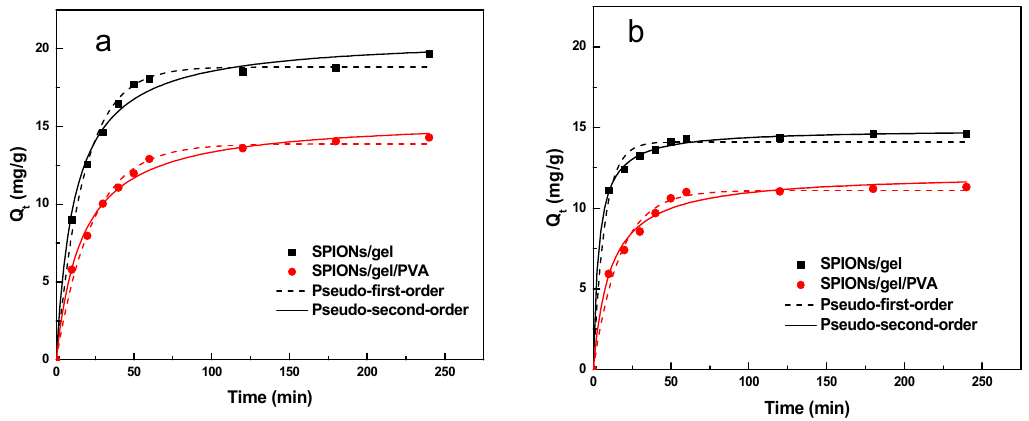
Figure 7. Adsorption kinetics for the adsorption of Cu(II) ( a ) and Zn(II) ( b ) by SPIONs/gel and SPIONs/gel/PVA.